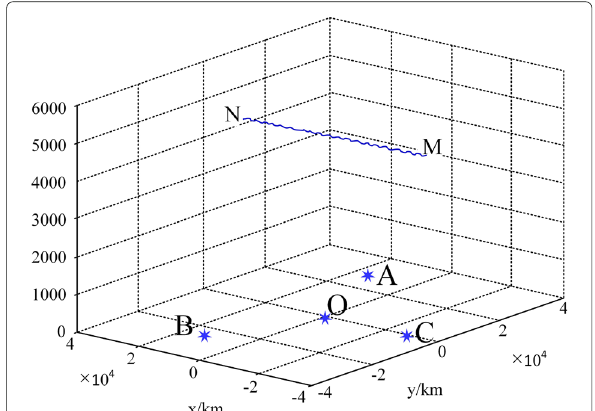
0, 0), (26, 15, 0), (-26, 15, 0), and (0, 30, 0), respec- tively. The unit is kilometer, the time measurement error is set to 10 ns, the angle between the base stations is = ϕ = 120 o , and the baseline length is L = ϕ 1 2 L 1 = L 2 = L 3 = 30 km. As shown in Fig. 6, the tar- get keeps uniform rectilinear motion at altitude 5 km above the x - y plane ( MN is the motion path). We aver- age over one hundred execution of the algorithms with different initialization and analyze the root mean square error of the target path to test the performance of the proposed hybrid algorithm. The analysis result is shown in Fig. 7. The minimum error is 5 m when the sampling sequence is between 40 and 70, which shows that the algorithm can effectively improve the three-dimensional positioning accuracy of the four-station TDOA position- ing system. And the maximum positioning error is less